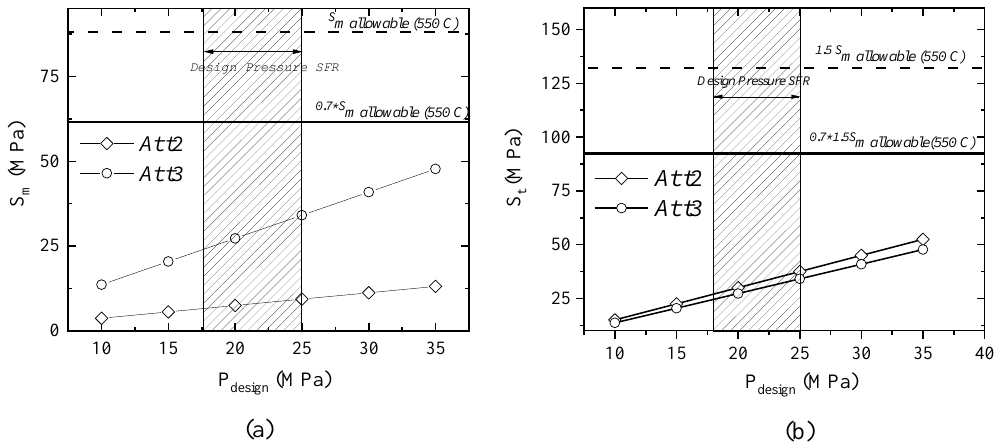
Figure 4. ( a ) Primary membrane stress ( b ) and the combined primary bending stress intensity under the different design pressure conditions.